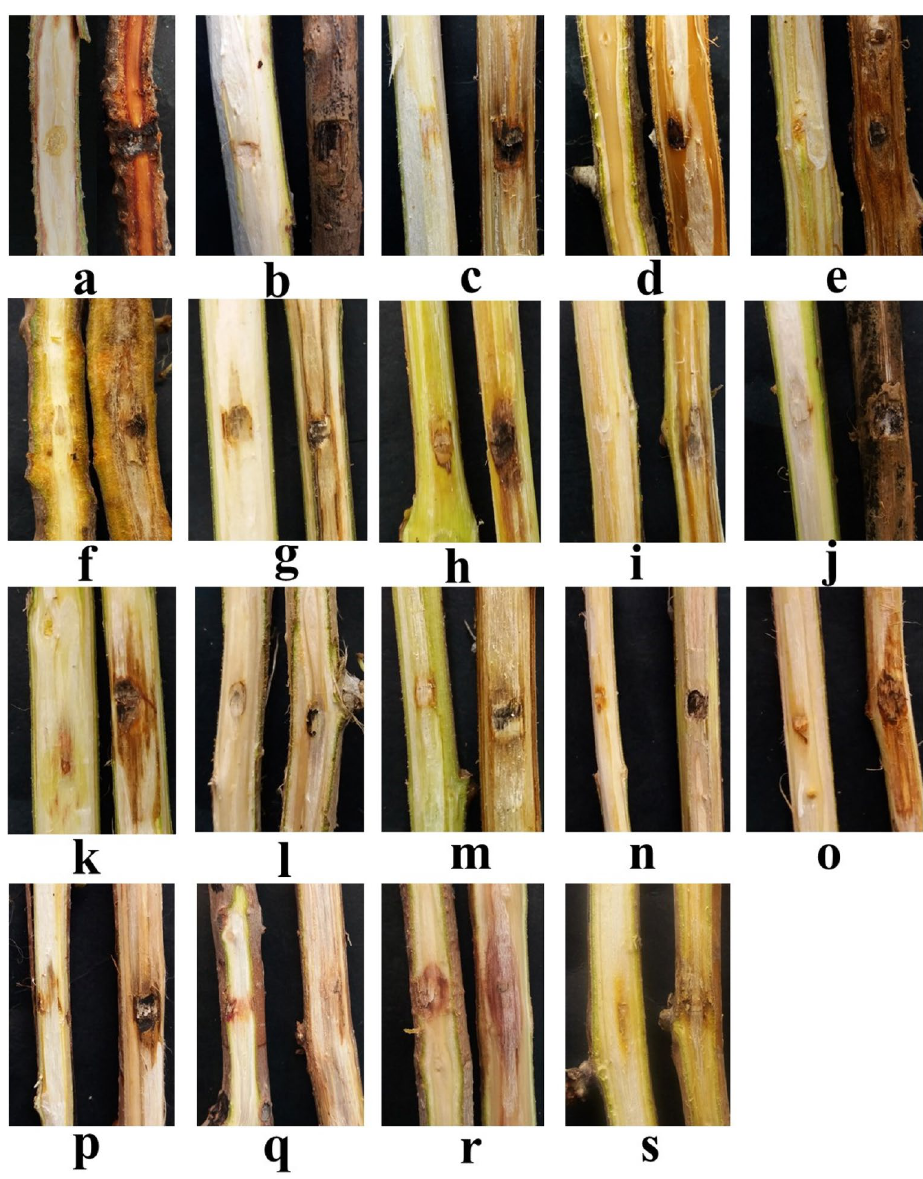
Figure 7. Pathogenicity tests on two-year old branches. There are two parts in each picture; negative control without symptom (left) and detached branch with lesion created by pathogen (right). Pine ( a ); willow ( b ); walnut ( c ); cypress ( d ); apricot ( e ); magnolia ( f ); ash ( g ); grape ( h ); chinaberry ( i ); poplar ( j ); pomegranate ( k ); ginkgo ( l ); sycamore ( m ); maple ( n ), elm ( o ); mulberry ( p ), catalpas ( q ), olive ( r ); ailanthus ( s ). All images are related to the lesions at 19–29